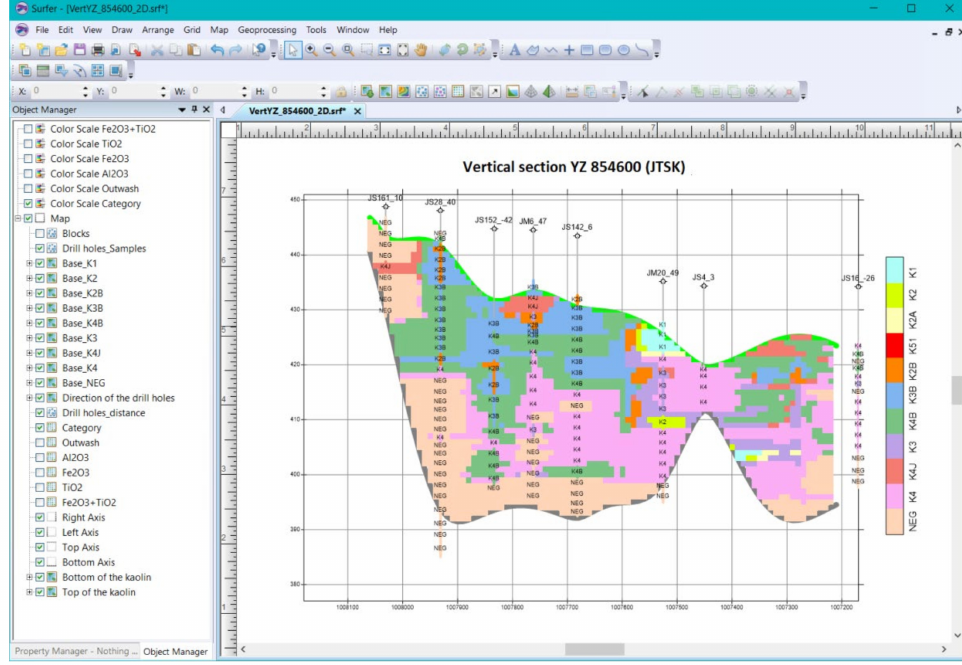
Figure 21. Visualization of vertical section YZ 854600 in the Surfer environment.